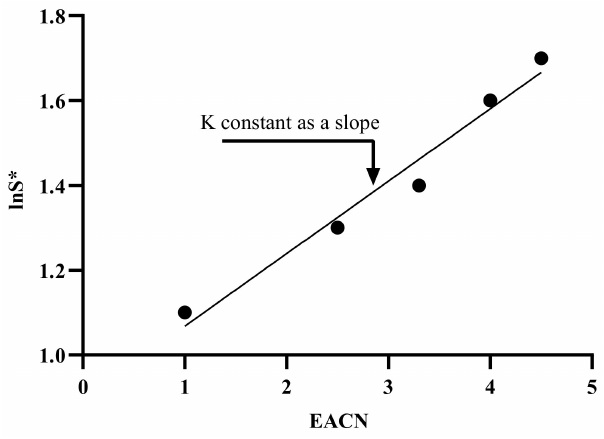
Figure 16. Determining K constants as the slope